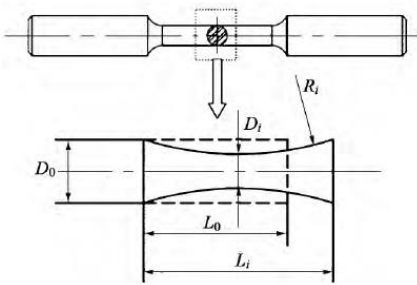
Figure 13. Deformation schematic of the necking section for the tension specimen.